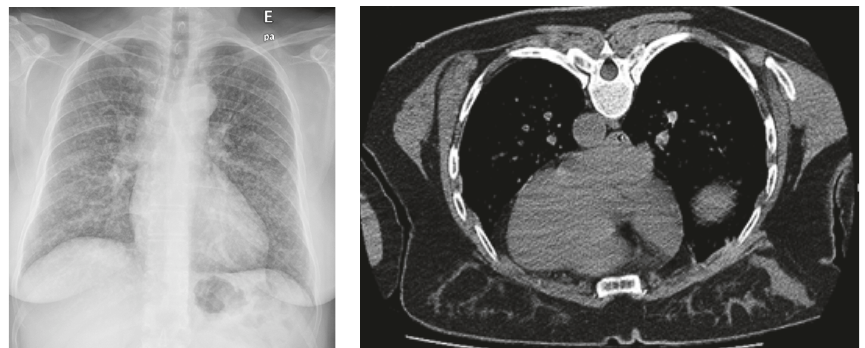
Figure 1: Chest radiography and CT images of patient 1.